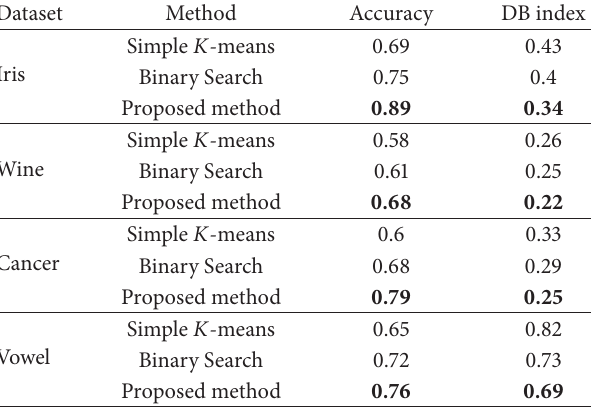
Table 3: Comparative analysis of the algorithms based on accuracy and DB